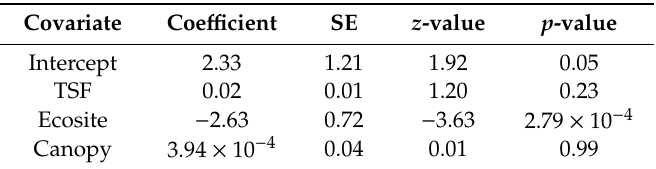
Table 5. Summary table for the top lichen presence model. TSF = time-since-fire, Canopy = canopy closure. The beta coe ffi cient for ecosite represents probability of occurrence for lichen in dense conifer with sparse conifer as the reference (Appendix C). SE = standard error.